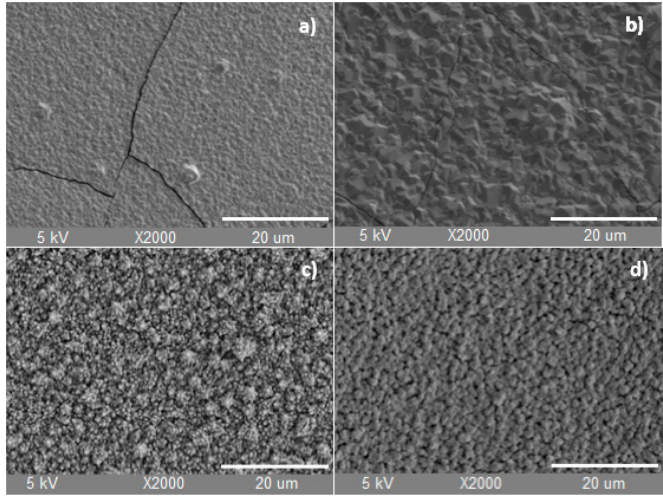
Figure 2. Scanning electron microscope (SEM) micrographs of the surface morphology of GaAs films deposited by CSVT technique having used H 2 and N 2 as gaseous atmospheres. ( a , b ) are the layers grown in hydrogen; 5 and 13 min, respectively. ( c , d ) are the layers grown in nitrogen; 5 and 13 min, respectively.